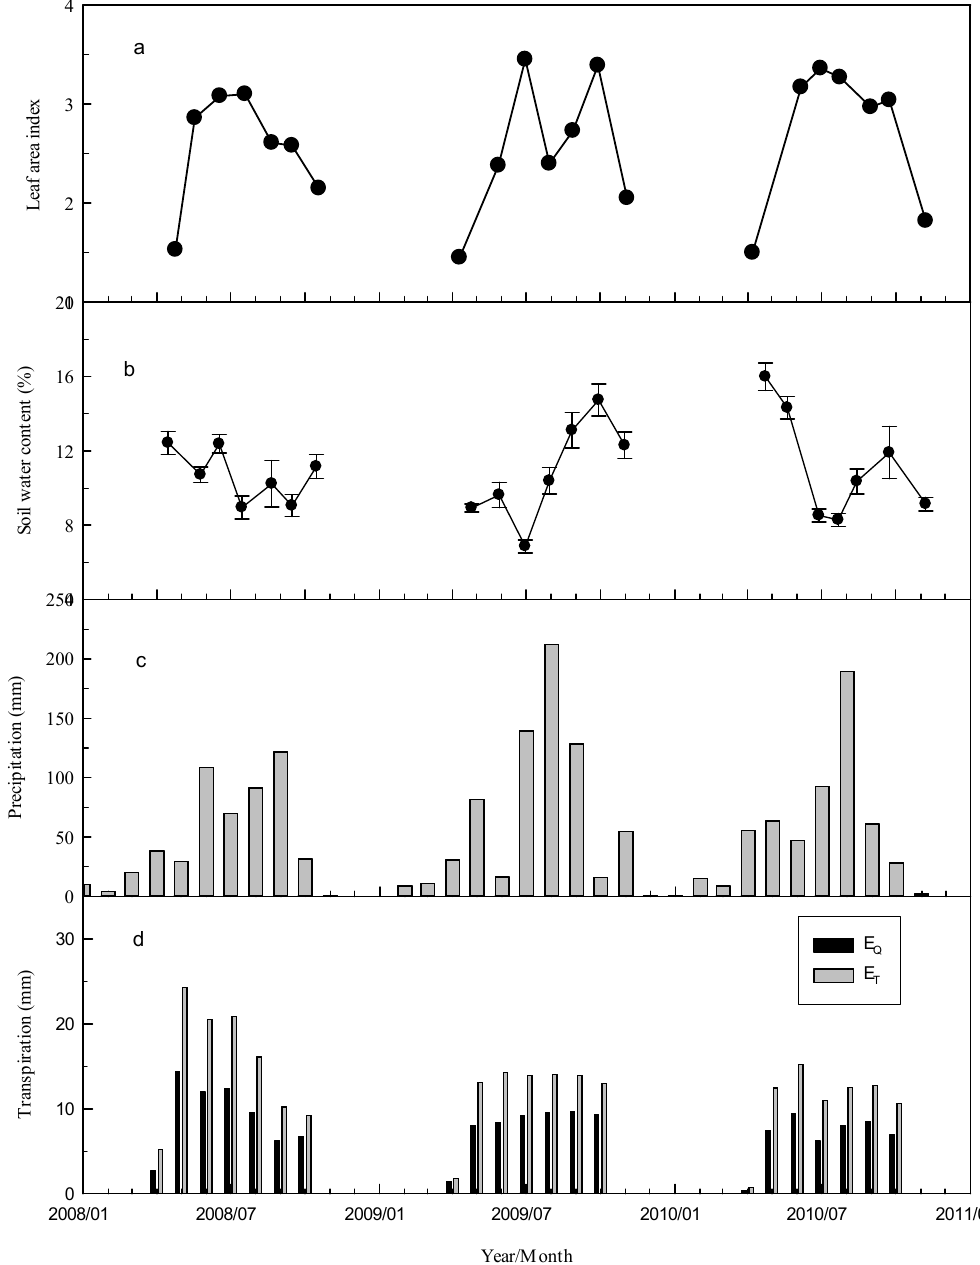
Figure 2. Leaf area index ( a ); volumetric soil water content ( b ); monthly precipitation ( c ); and stand transpiration ( d ) for the site in 2008–2010. Precipitation is presented for all months, while other variables cover growing seasons only. Soil water contents are averages from three 1-m depth profiles. Transpiration estimates are presented for oak trees ( E Q ) and all trees ( E T ) in the plot.